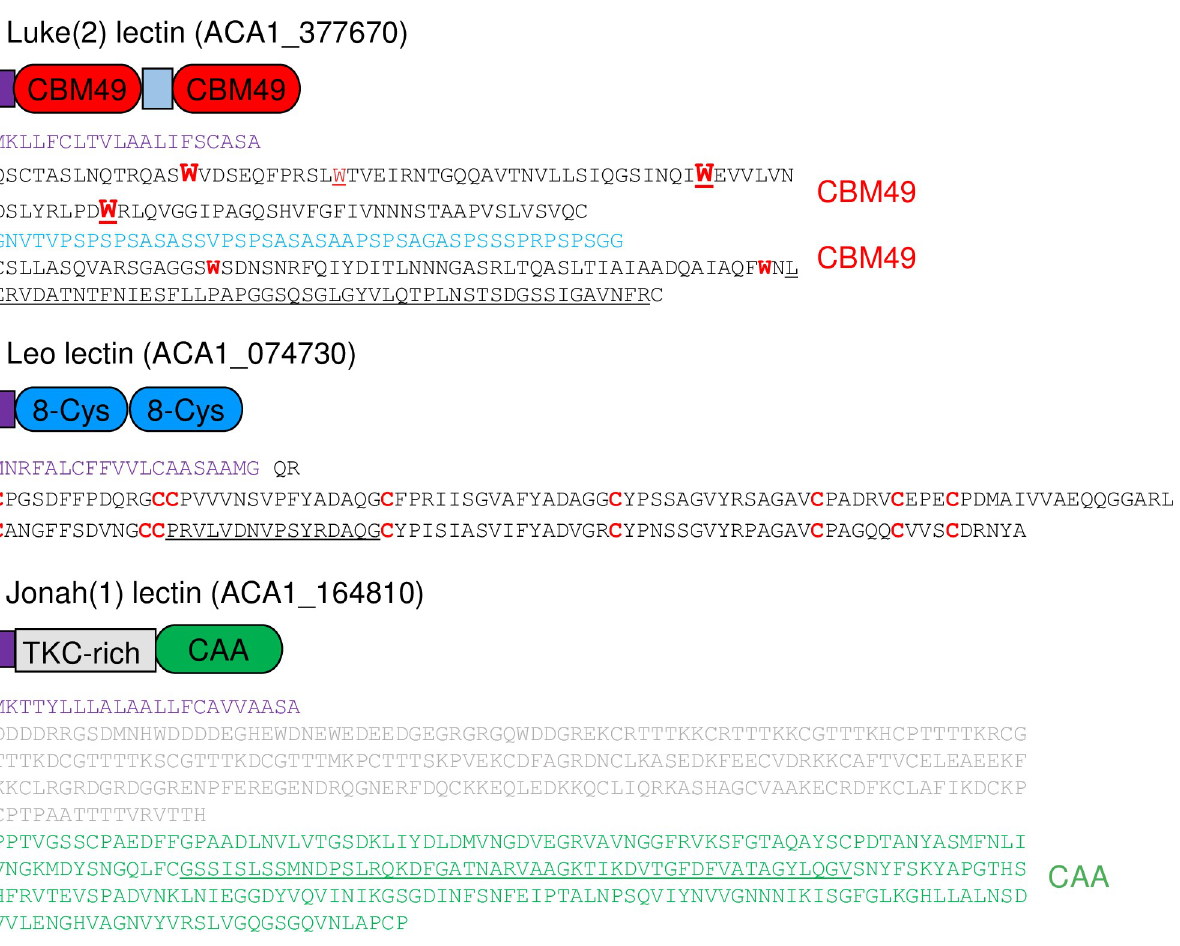
Fig 3. Abundant cyst wall proteins contained two CBM49s (Luke(2) lectin), two 8-Cys domains (Leo lectin), or one CAA domain (Jonah(1) lectin). The Luke(2) lectin had an N-terminal signal peptide (purple) and two CBM49s separated by short Ser- and Pro-rich spacers (light blue). The N-terminal CBM49 contained four Trp residues (red Ws), three of which were conserved in a C-terminal CBM49 of a tomato cellulase (larger font) and three of which were conserved in a single CBM49 of Dictyostelium cellulose-binding protein (XP_629733) (underlined). In contrast, the C- terminal CBM49 had two conserved Trp residues. The Leo lectin had a signal peptide and two unique domains (dark blue) containing eight Cys residues each (red Cs). The Jonah(1) lectin had a signal peptide, a Thr-, Lys-, and Cys-rich domain (gray), and a single CAA domain (green). Peptides used to immunize rabbits are underlined. An abundant Luke(3) lectin with three CBM49s, Leo(TKH) lectin with a Thr-, Lys-, and His-rich spacer, and an abundant Jonah(3) lectin with three CAA domains are shown in S2 Fig.